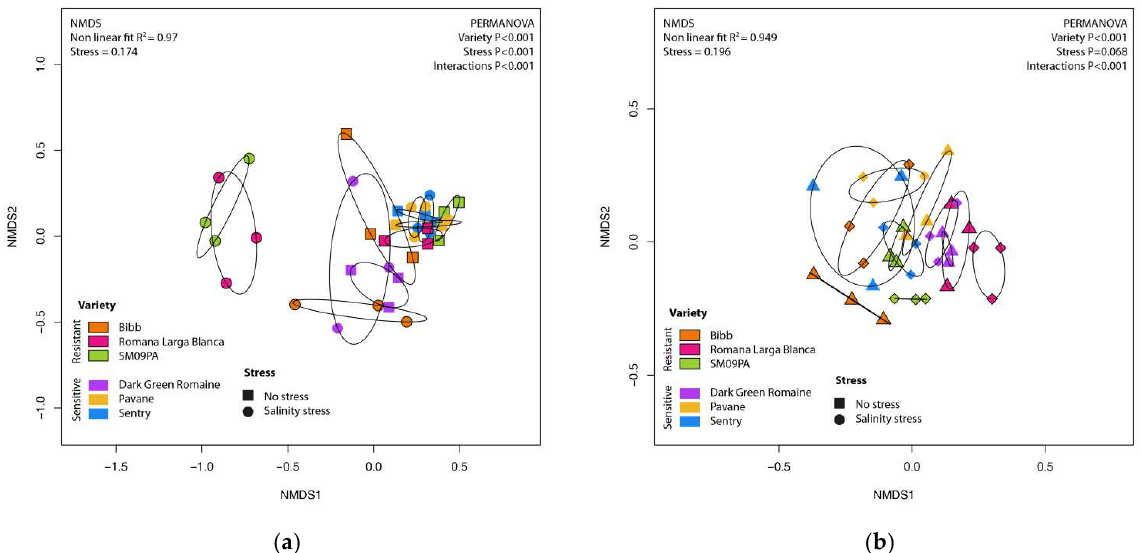
Figure 1. NMDS scatterplot of bacterial community in roots ( a ) and rhizosphere ( b ) of six lettuce varieties in normal conditions and under salinity stress.